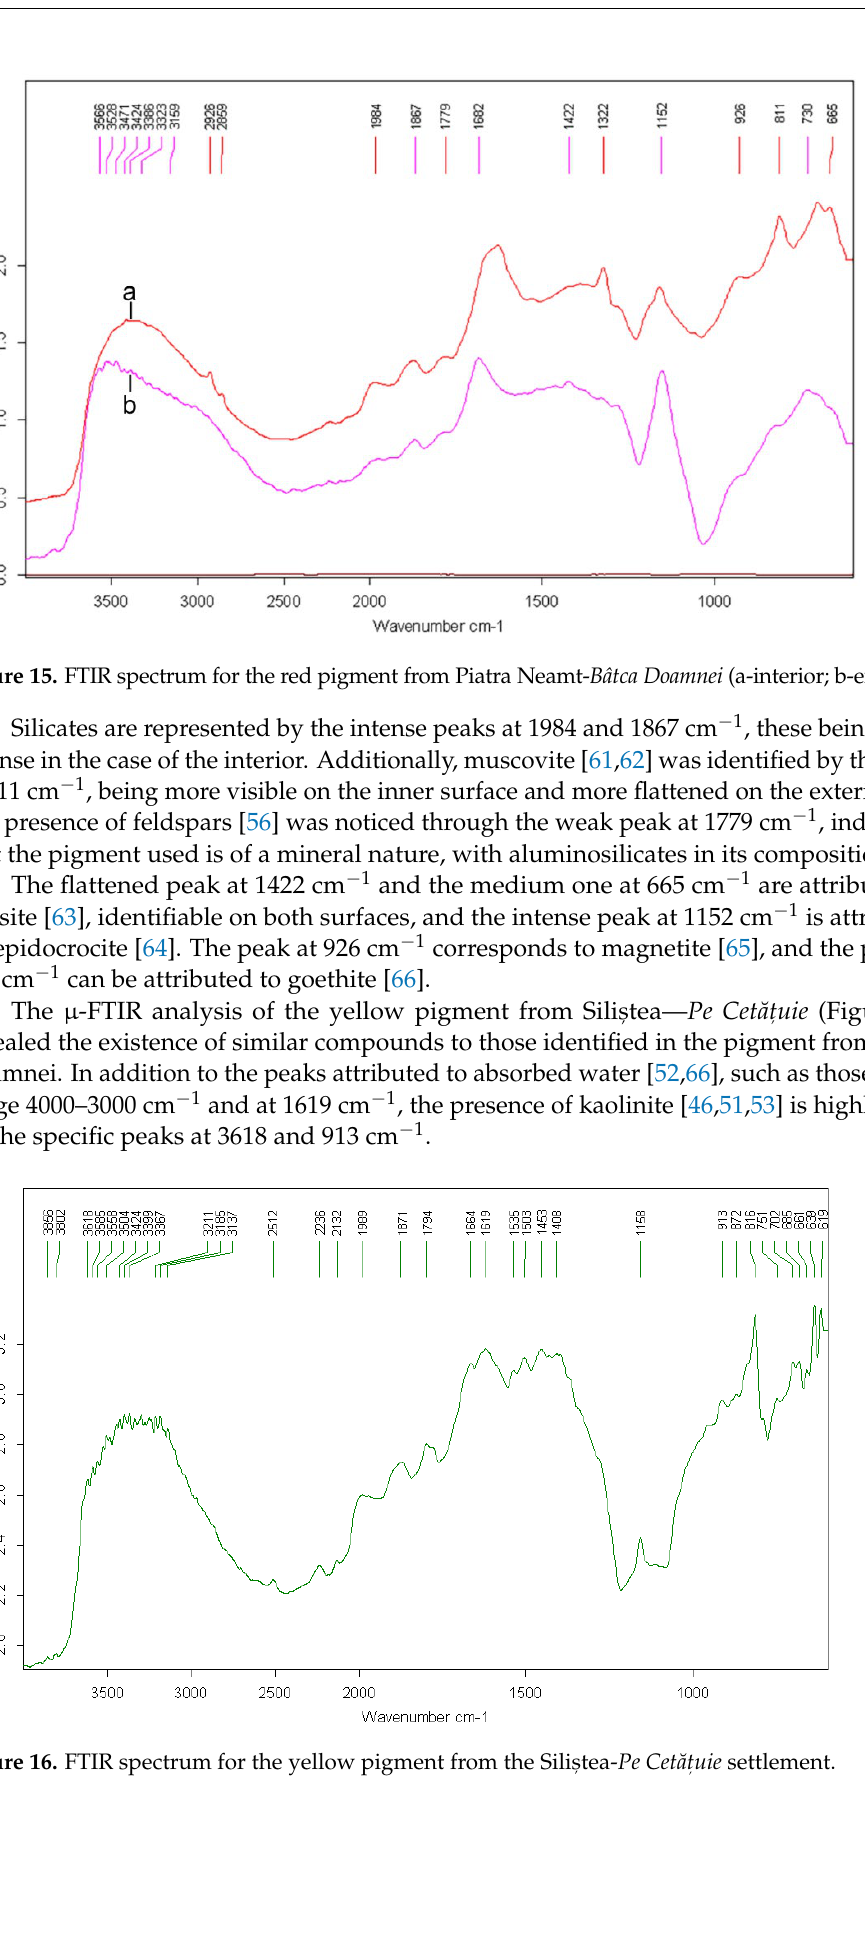
15 of 23 Figure 14. The elemental composition of the yellow pigment from the Siliștea — Pe Cetățuie settle-